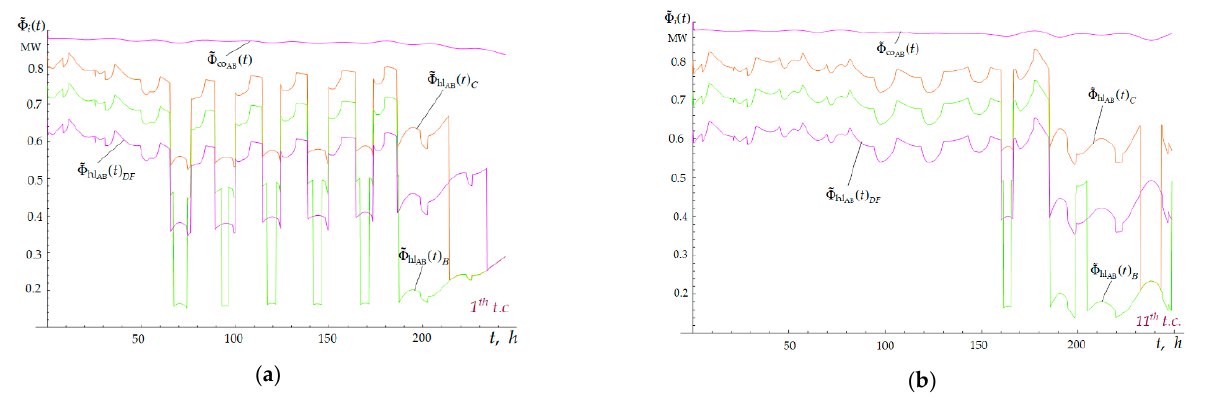
Figure 19. Heating effect of LP cogeneration (cid:101) Φ co and 11th transport cycle for navigation from A to B for ( a ) 1st and ( b ) 11th transport cycle.